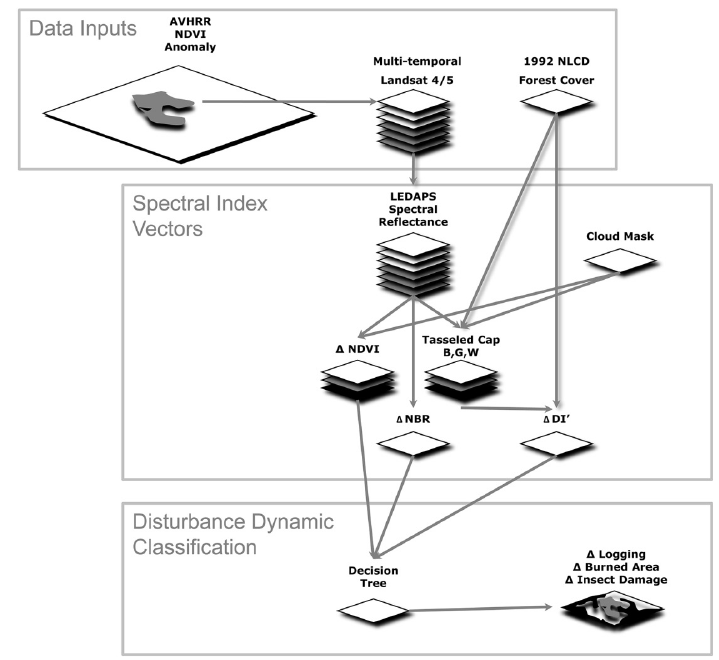
Figure 2. Chart illustrating the image classification procedure adapted from our previous study